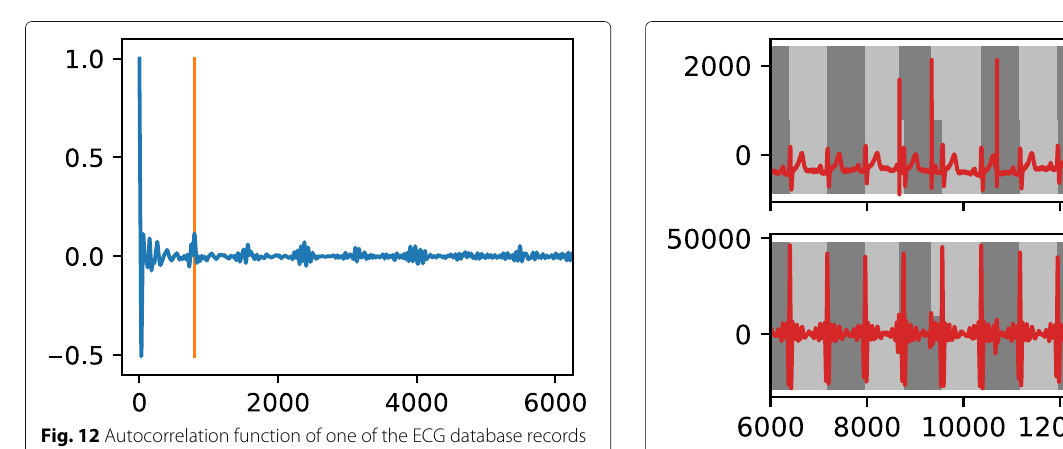
Fig. 13 Comparison of periods detected in the steps 3 and 6 thods: distance-basedapproachesemploying various types of E uclidean distance comparison (cf. “Self-similarity approach” and “Distance-based phase classification” sections) and one-step ahead forecasting (cf. “Long short-term memory predictor approach” section). In the first class of